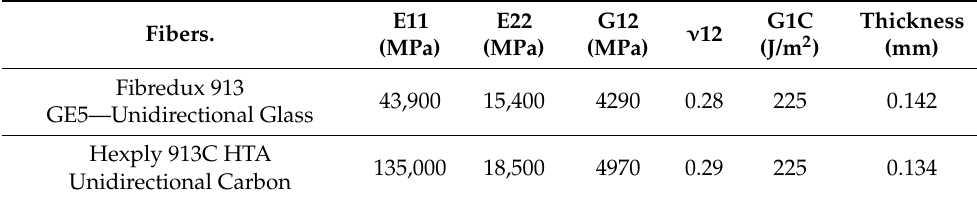
Table 2. In-plane material properties of unidirectional layers in sandwich faces under compression.